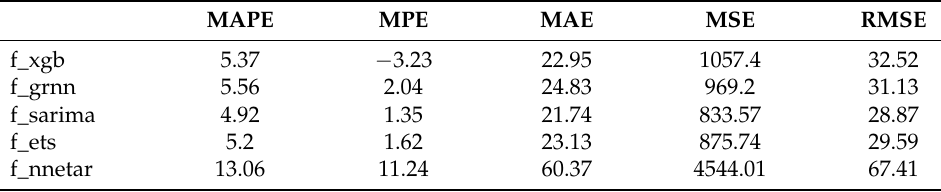
Table A2. Monthly forecast error measure.